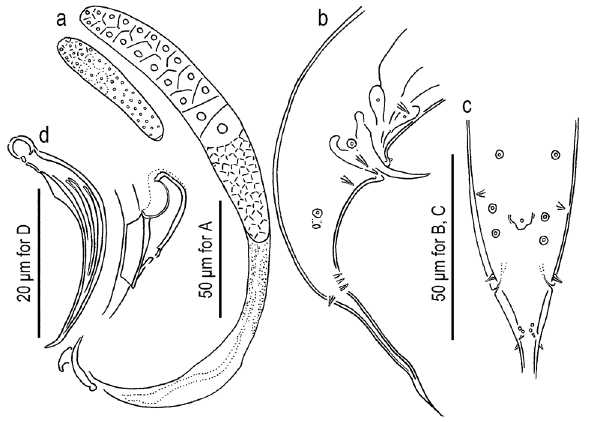
Figure 3. Adult male of Onthodiplogaster japonica n. gen., n. sp. ( a ) Gonad in left lateral view where reflexed part is drawn separately; ( b ) entire tail in right lateral view; ( c ) cloacal region in ventral view; ( d ) spicule and gubernaculum in left lateral view.